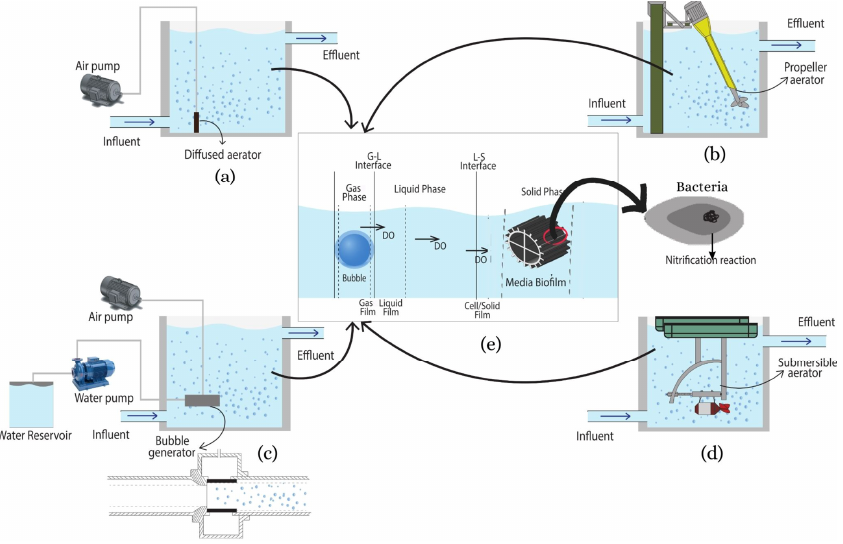
Figure 3. Oxygen transfer at various types of bubble aerators( a ) diffused aerator; ( b ) propeller aerator; ( c ) bubble generator; ( d ) submersible aerator, and ( e ) transfer oxygen process in the biofilter.